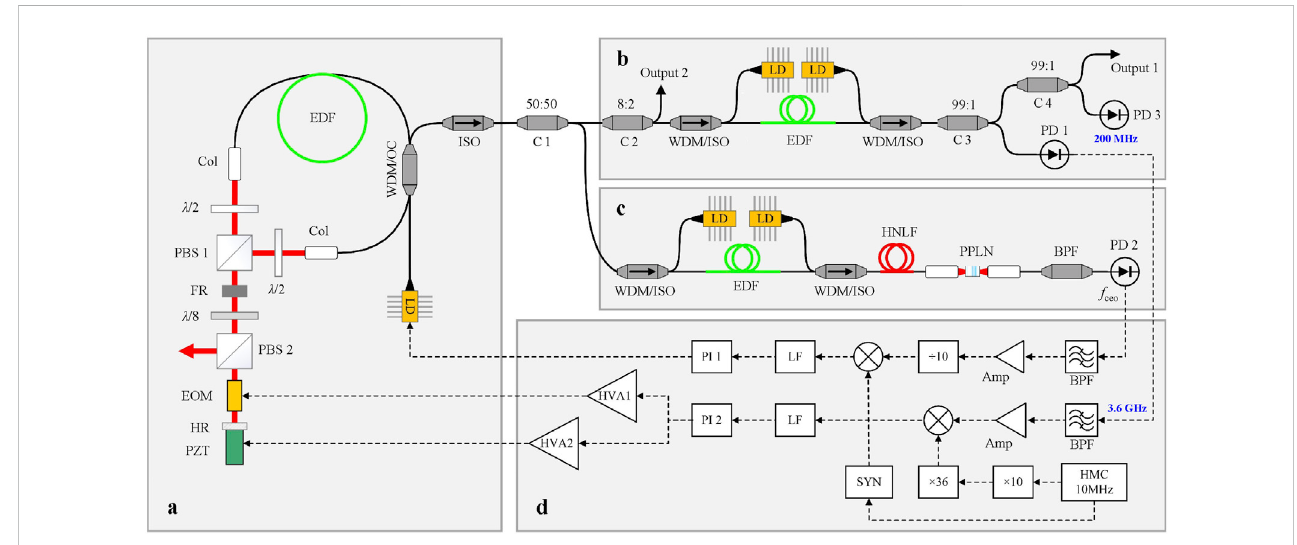
FIGURE 1 The schematic diagram of the optical frequency comb. (a – d) are the oscillator (a) , the optical power ampli fi cation unit (b) , the f ceo generation and detection unit (c) , and an electronic control unit (d) , respectively. LD, laser diode; WDM, 980 nm/1,550 nm wavelength division multiplexer; Col, fi ber collimator; EDF, Er-doped fi ber; λ /2, half-wave plate; λ /8, eighth-wave plate; FR, Faraday rotator; PBS, polarizing beam splitter cube; EOM, electro-optic modulator; HR,highre fl ector; PZT,piezoelectricactuator;ISO,isolator;C1-C4, coupler; HNLF, high-nonlinear fi ber; PD,photodetector;BPF,bandpass fi lter; AMP, ampli fi er; SYN: synthesizer; PI, proportional integral controller; HVA, high voltage ampli fi er; LF, loop fi